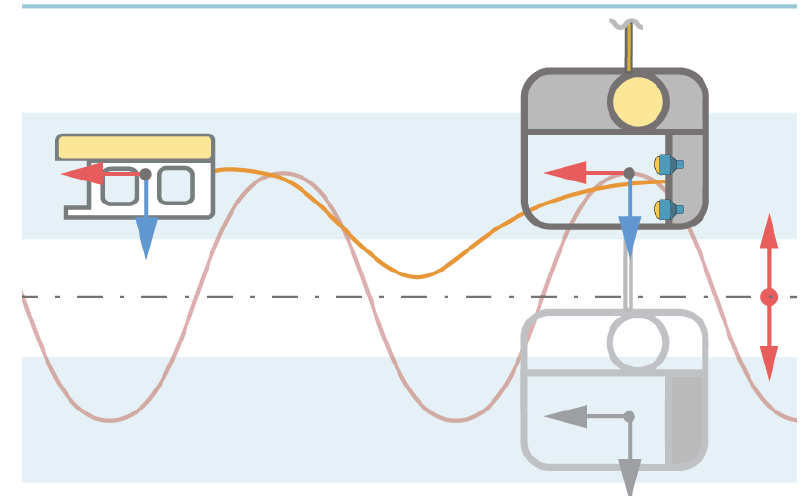
Figure 4. The ROV docking procedure. Red line presents the TMS heave motion, whereas blue shaded area shows optimal docking position with minimal TMS heave